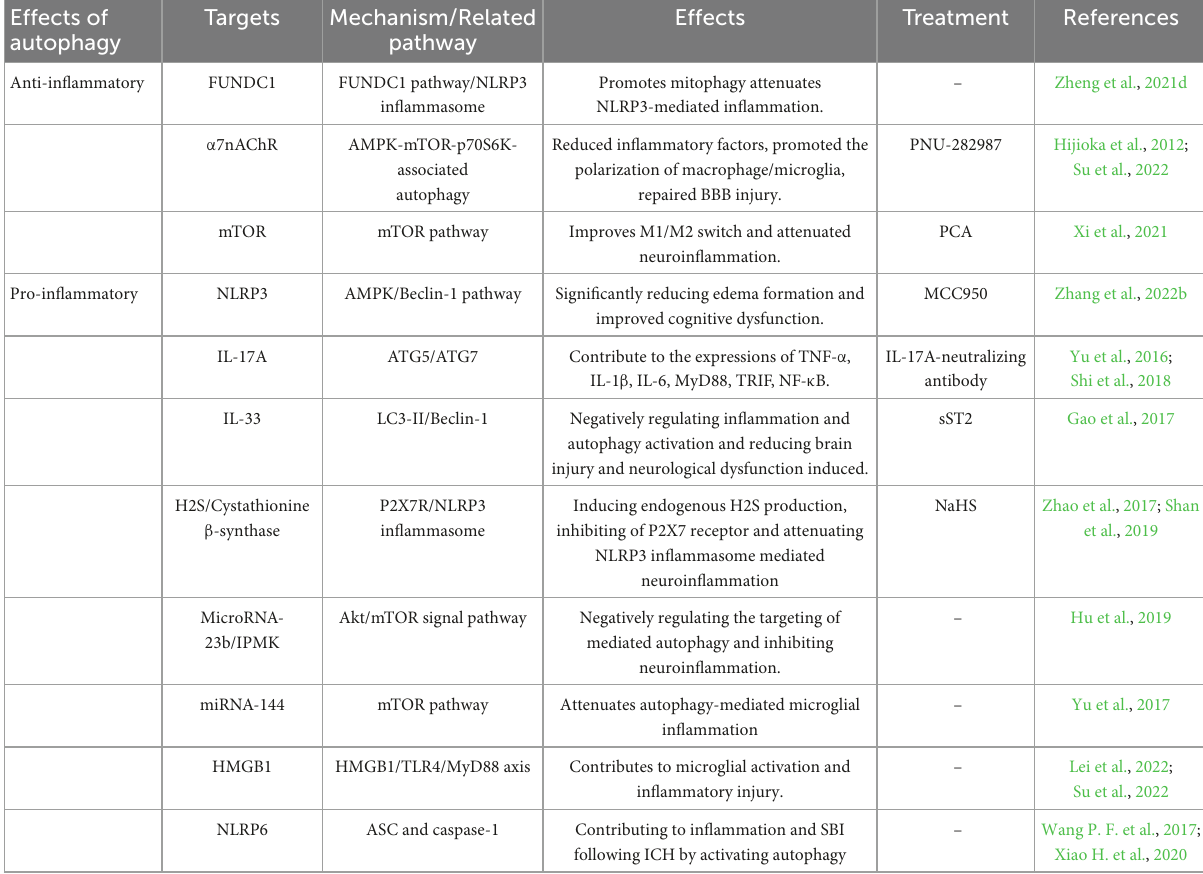
TABLE 3 Summary of potential targets related to autophagy and inflammation for